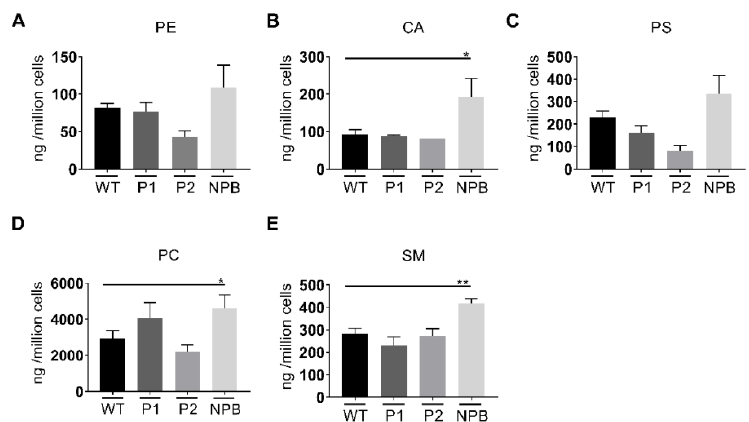
Figure 4. Lipid analysis from total cell lysates. PE (phosphoethanolamine, A ), CA (cardiolipin, B ), PC (phosphatidylserine, C ), PC (phosphatidylcholine, D ) and SM (sphingomyelin, E ) were analysed by TLC. Concentrations are given as ng cholesterol per 1 × 10 6 cells. Each bar equates to at least three repetitions, with the WT corresponding to the average of three repetitions of three WT fibroblasts from independent healthy donors. P1: NPC-I1061T/P887L, P2: NPC-D874V/D948Y. SEM, Student’s t-test * p ≤ 0.05, ** p ≤ 0.01. n = 3–11.